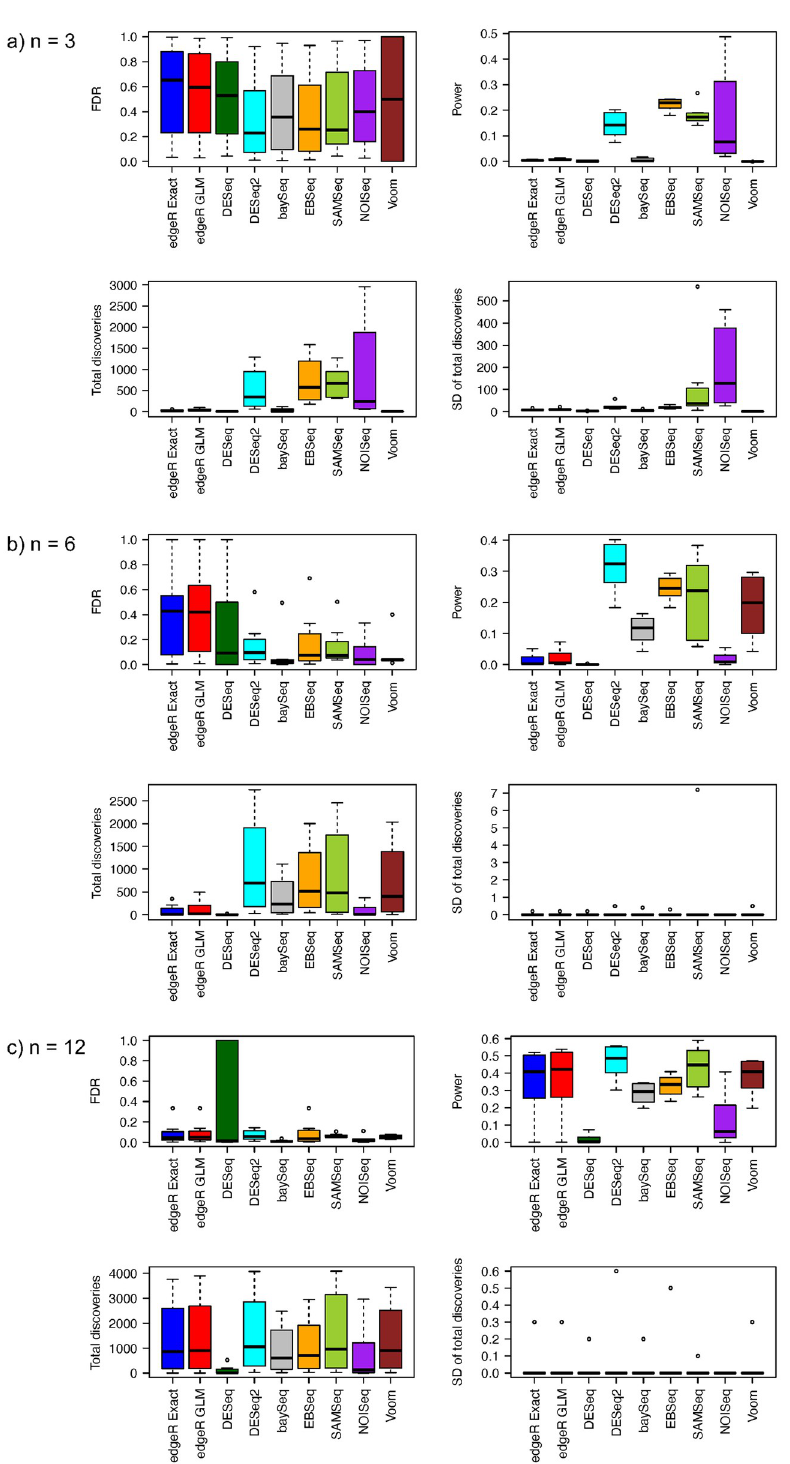
Fig 2. Estimated FDRs, powers, means of total discoveries, and SD of total discoveries from different RNA-Seq differential analysis methods with negative binomial distribution assumption and unequal library size for a) n = 3, b) n = 6, and c) n =